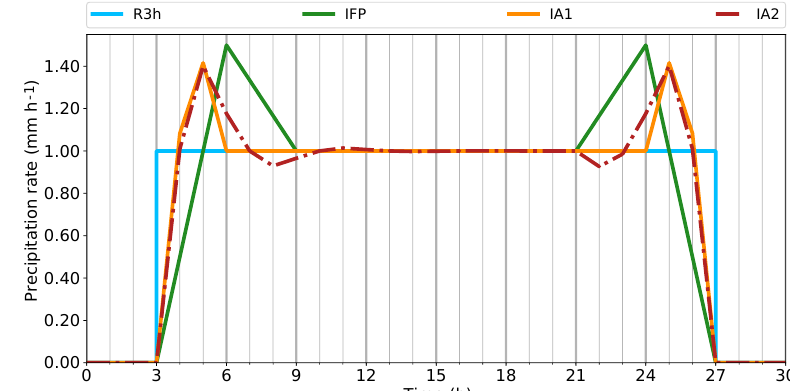
Figure 11. Verification of the different behaviour of the interpolation algorithms for a longer constant precipitation event plotted in mmh − 1 . The 3-hourly synthesised precipitation rate (S3h) is illustrated as a step function in light blue, the old interpolation algorithm of FLEXPART (IFP) in green and the newly developed algorithms IA1 and IA2 are shown in orange and red (dashed–dotted), respectively.